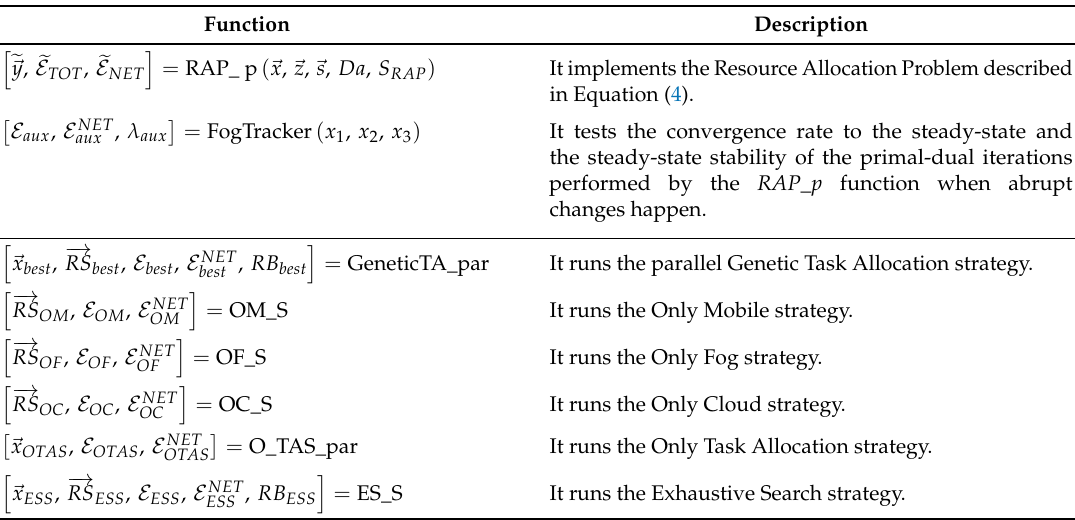
Table 2. Main functions implemented by VirtFogSim